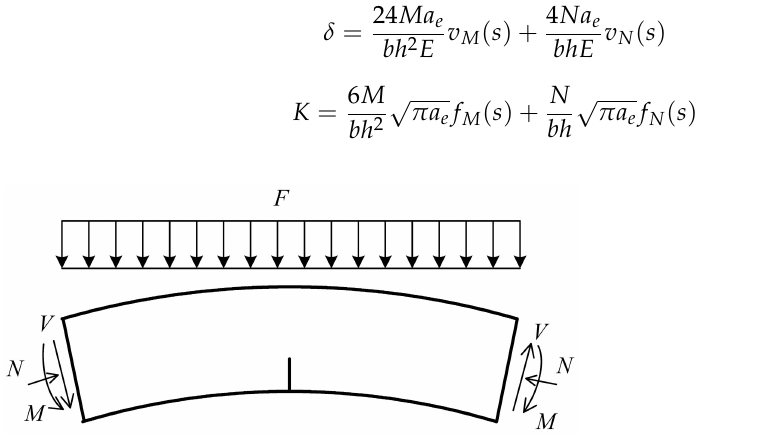
Figure 4. A lining segment containing a